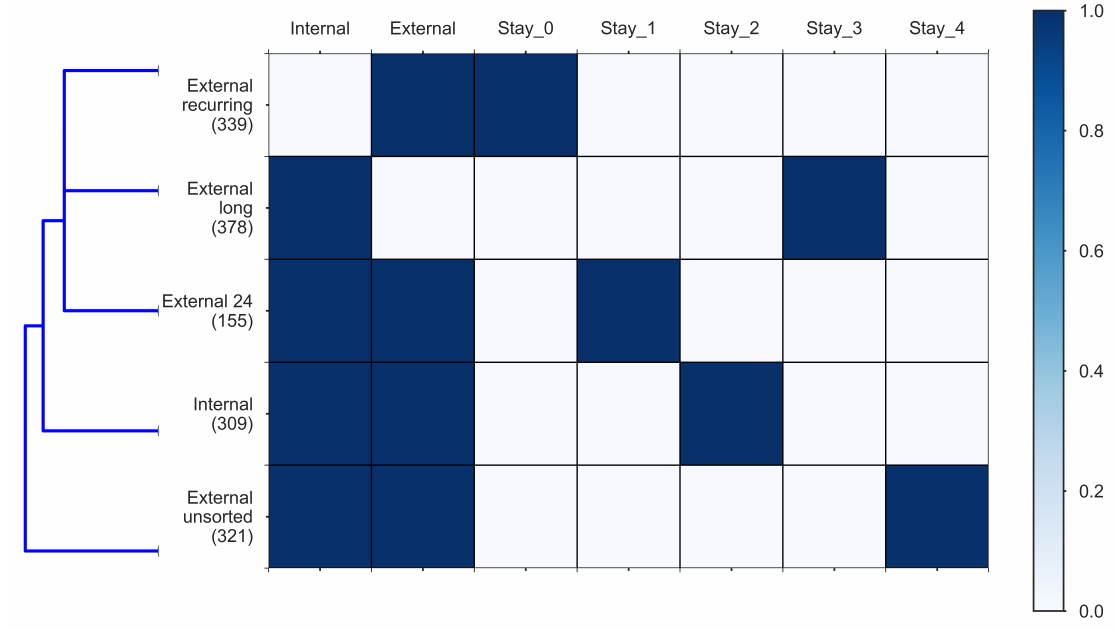
Figure 7. Heat map of tourist segments vs. dataset features.